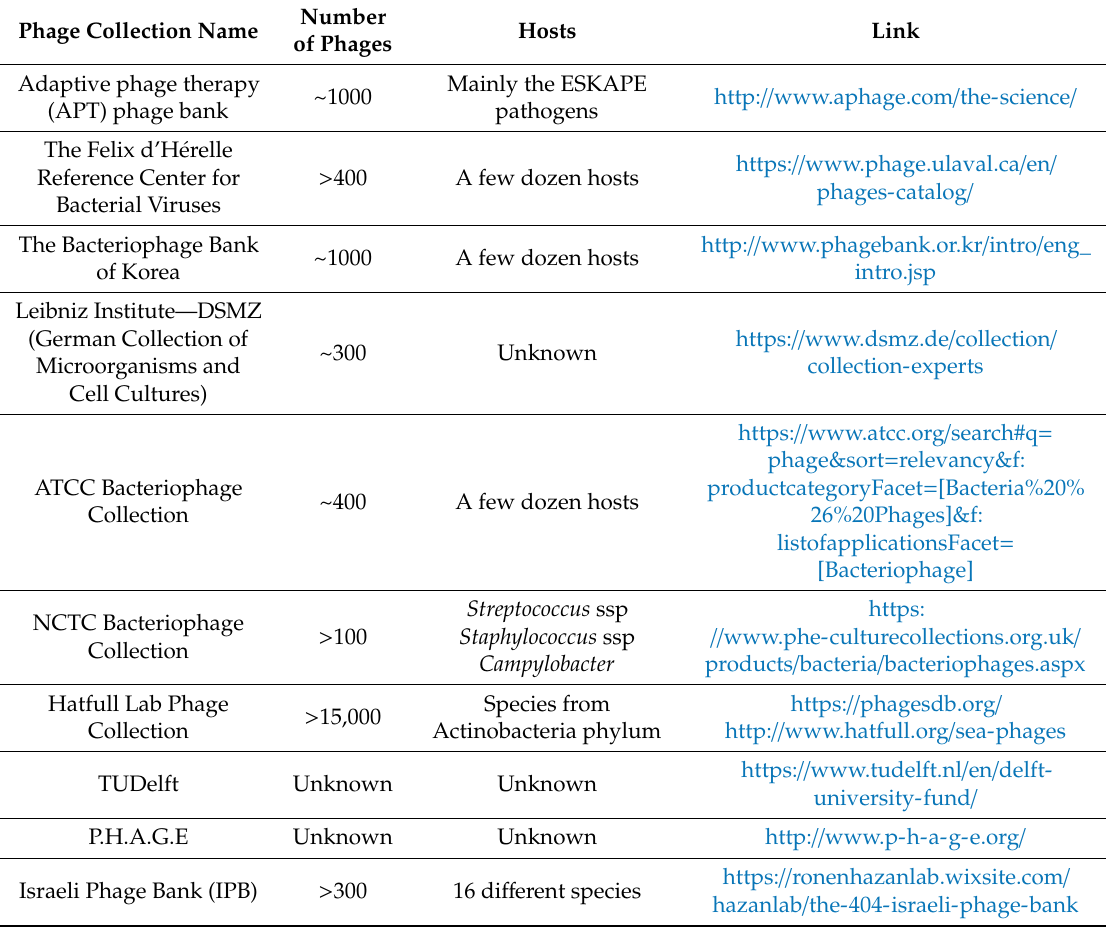
Table 1. Phage collections